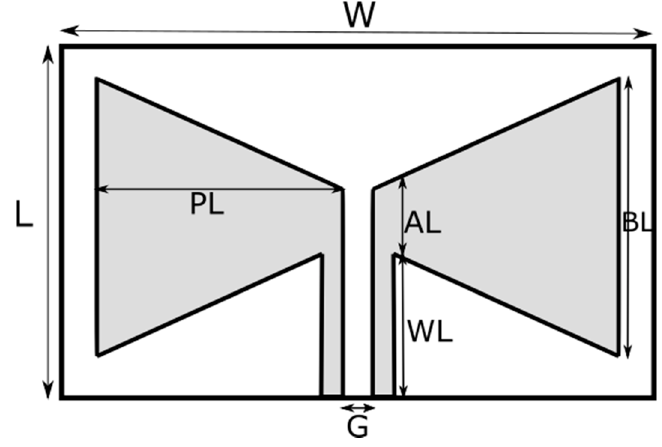
Figure 2. The design geometry of Antenna-1.